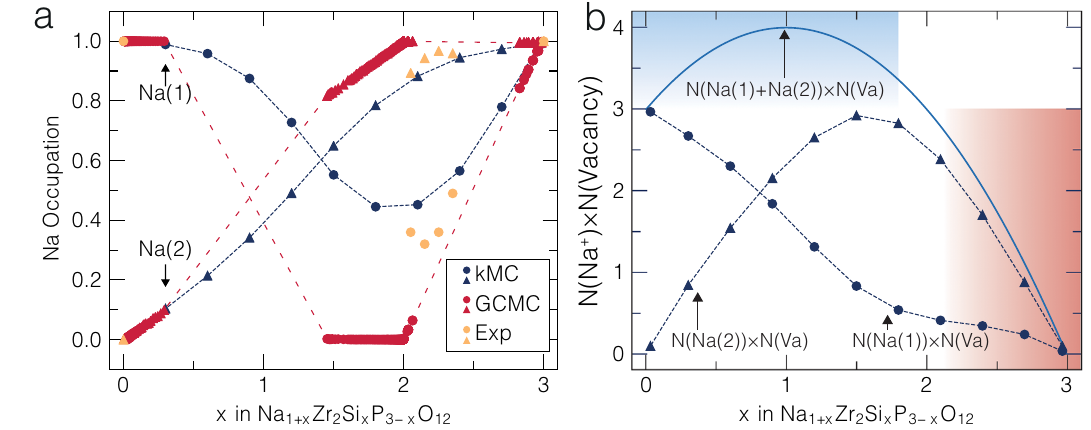
Fig.3|SodiumsiteoccupanciesasafunctionofNacontent. Panel( a )showsthe average Na site occupancy at the Na(1) site (blue circles) and the Na(2) site (blue triangles) from the kMC simulations at 443K; they are compared with previous Grand Canonical Monte Carlo simulations 19 (red circles and triangles) at the same temperature, and existing experimental data 30 (in orange circle and triangles). Dashed lines are used as guide for the eye. Panel b shows N ð Na + Þ ×N Vacancy ð Þ